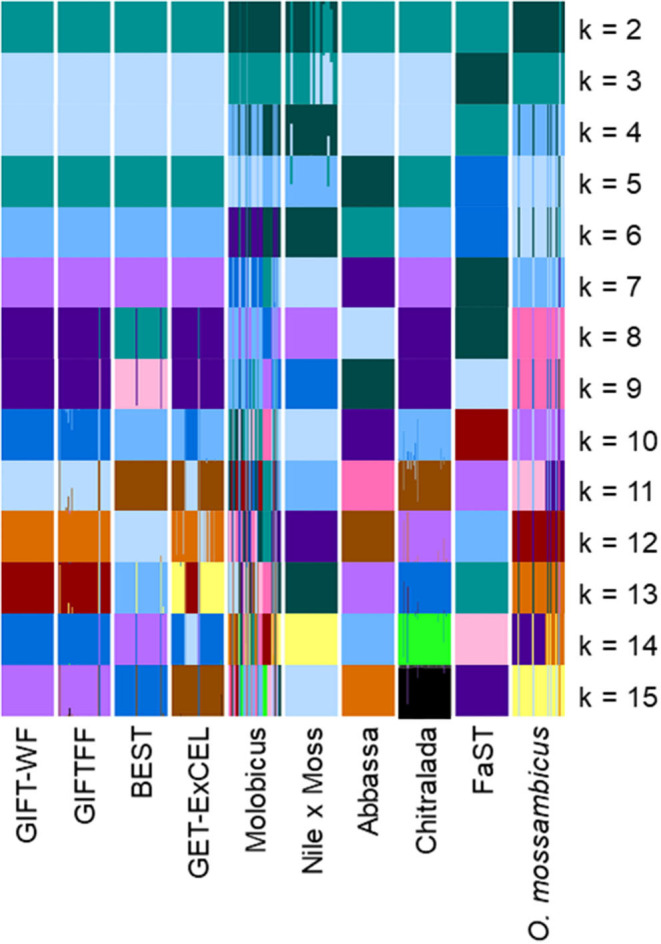
Unsupervised k-means clustering of individuals in core breeding populations performed using discriminant analysis of principal components (DAPC) for differing numbers of groups (k) using the full DArTseq panel. Each of the groups is represented by a different color. Vertical lines represent the cluster membership probability of individuals.